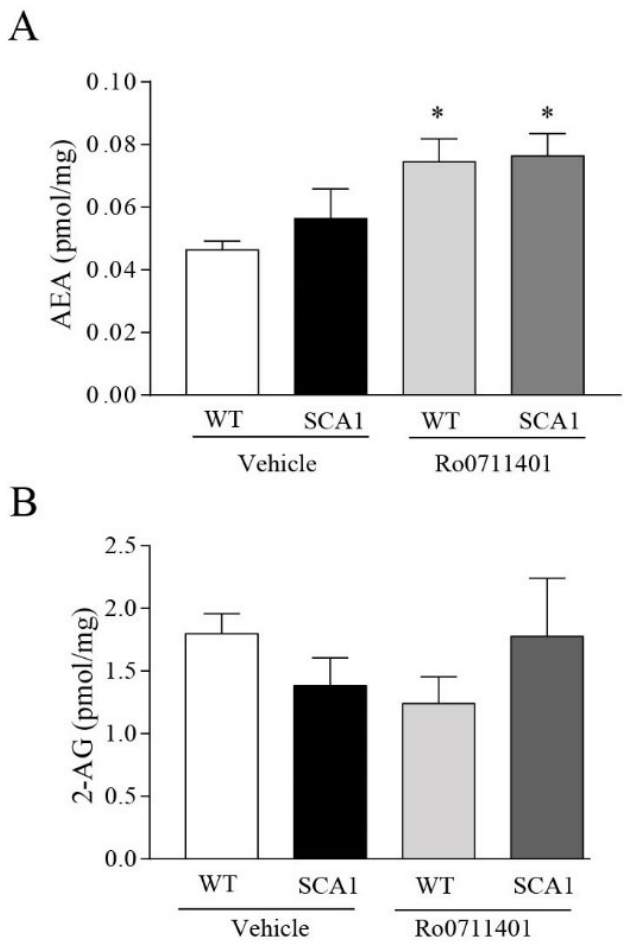
Figure 5. Increased hippocampal levels of AEA in 8-week-old SCA1 mice and their wild-type littermate treated with Ro0711401. Increased AEA hippocampal levels in the SCA1 mice model and wild-type littermates treated with Ro0711401 are shown in ( A ), while no changes in hippocampal 2-AG levels are shown in ( B ). * p < 0.05 vs. WT vehicle. Statistical analysis was performed by two-way ANOVA + Bonferroni test. Genotype, F 1,18 = 0.7344, p = 0.4027; treatment, F 1,18 = 12, p = 0.0028; interaction, F 1,18 = 0.3286, p = 0.5735. Values are means ± SEM of 5–6 ( A ) and 6–7 ( B ) mice. Hippocampal levels of MAGL and DAGL- β did not differ between the two genotypes and were not affected by Ro0711401 treatment (DAGL- α could not be detected with our antibody) (Figure 6A,B). In contrast, hippocampal levels of the AEA synthesizing enzyme, NAPE-PLD, were reduced, and levels of the AEA-degrading enzyme, FAAH, were in- creased in SCA1 mice treated with Ro0711401, as compared to wild-type mice treated with the vehicle or Ro0711401 (Figure